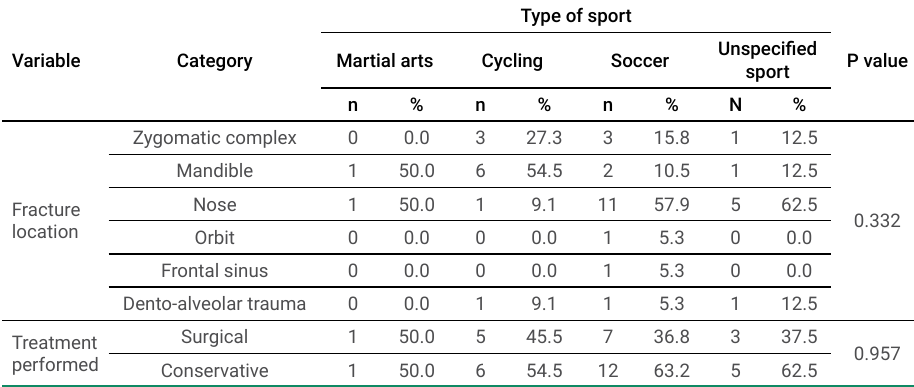
Table 3. Distribution of patients by fracture location and treatment performed according to the type of sport and likelihood ratio test significance.